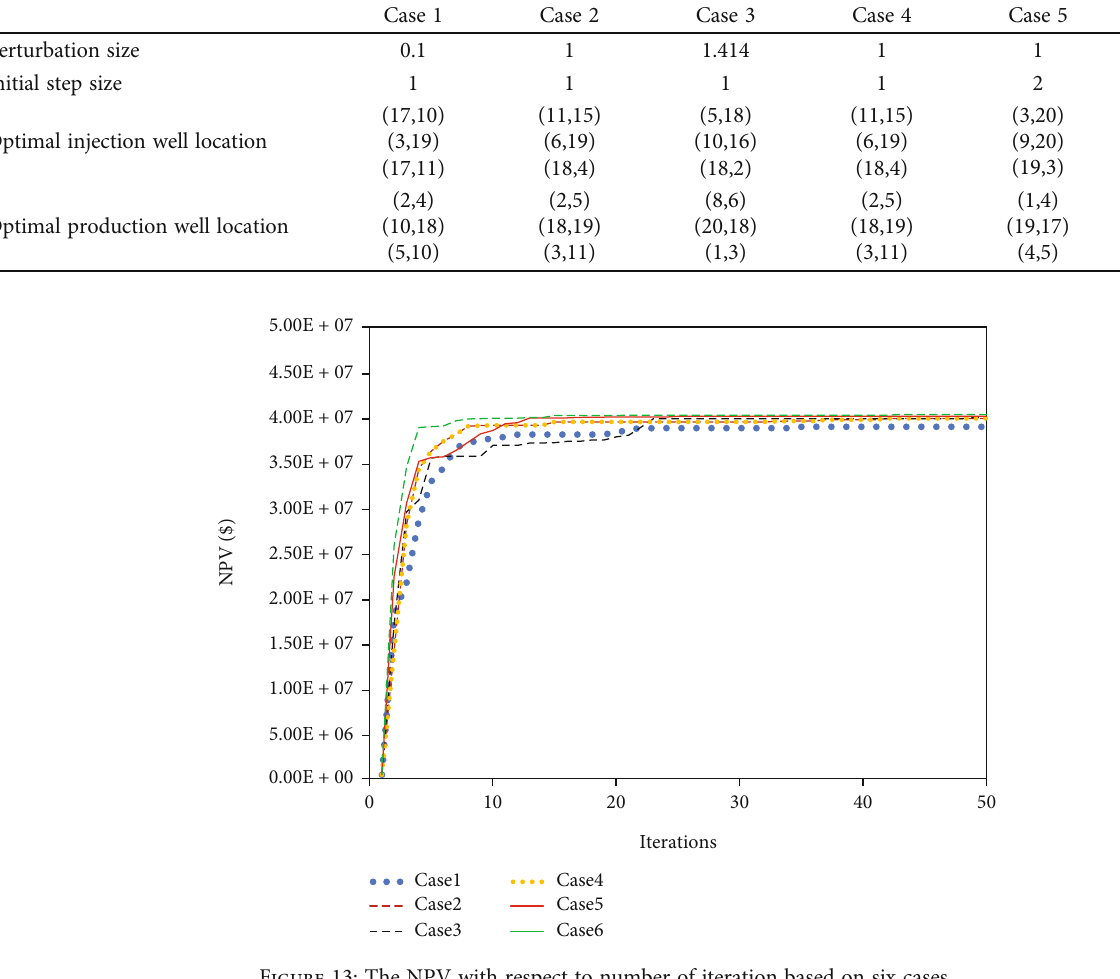
Figure 13: The NPV with respect to number of iteration based on six cases.